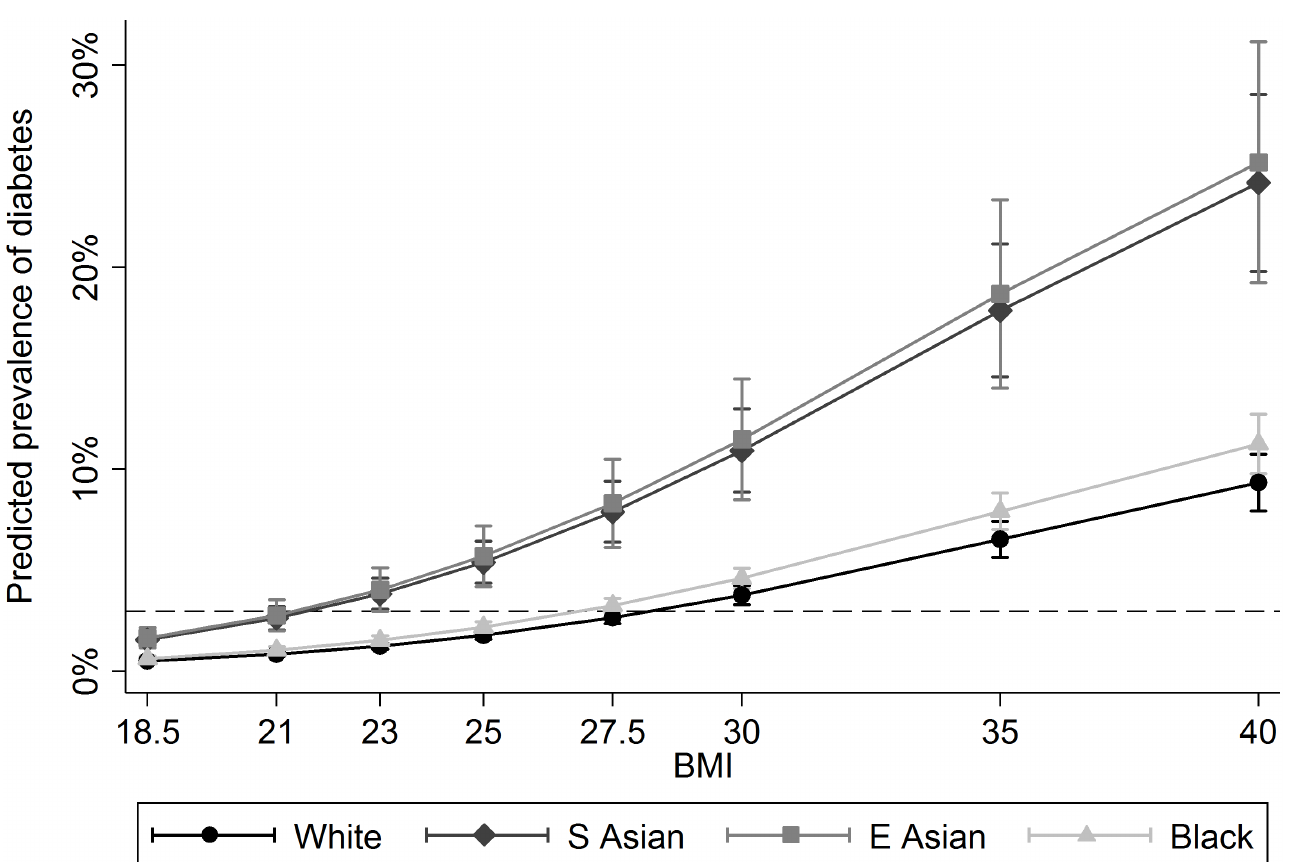
Fig 2. Predicted prevalenceof diabetes by BMI and ethnic group.